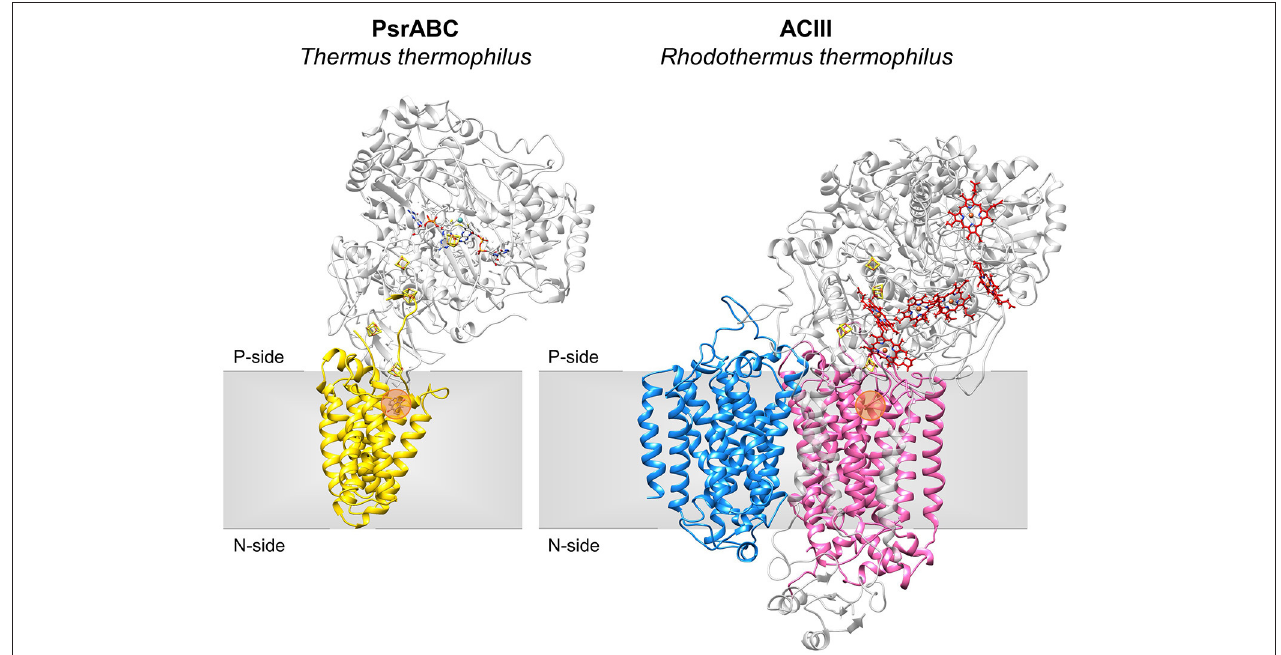
FIGURE 2 | Structures of NrfD-like subunit-containing complexes. Overall structure of PsrABC from Thermus thermophilus (left, PDB: 2VPZ) and Alternative Complex III from Rhodothermus marinus (right, PDB: 6FOK, ActH was not included for clarity). PsrC (yellow), ActC (pink) and ActF (blue) are NrfD-like subunits. The two complexes are oriented in relation to each other by the superimposition of the PsrC and ActC subunits. Iron-sulfur clusters represented by orange/yellow spheres; Cytochrome c -type hemes represented by red sticks; Mo- bis PGD cofactor represented by blue/red sticks with molybdenum shown as a blue sphere. Orange dots stand for the quinone-binding site. P-side, positive-side of the membrane; N-side, negative-side of the membrane.